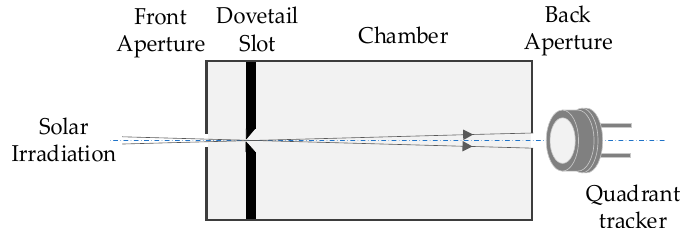
Figure 2. Sun tracking light-path.